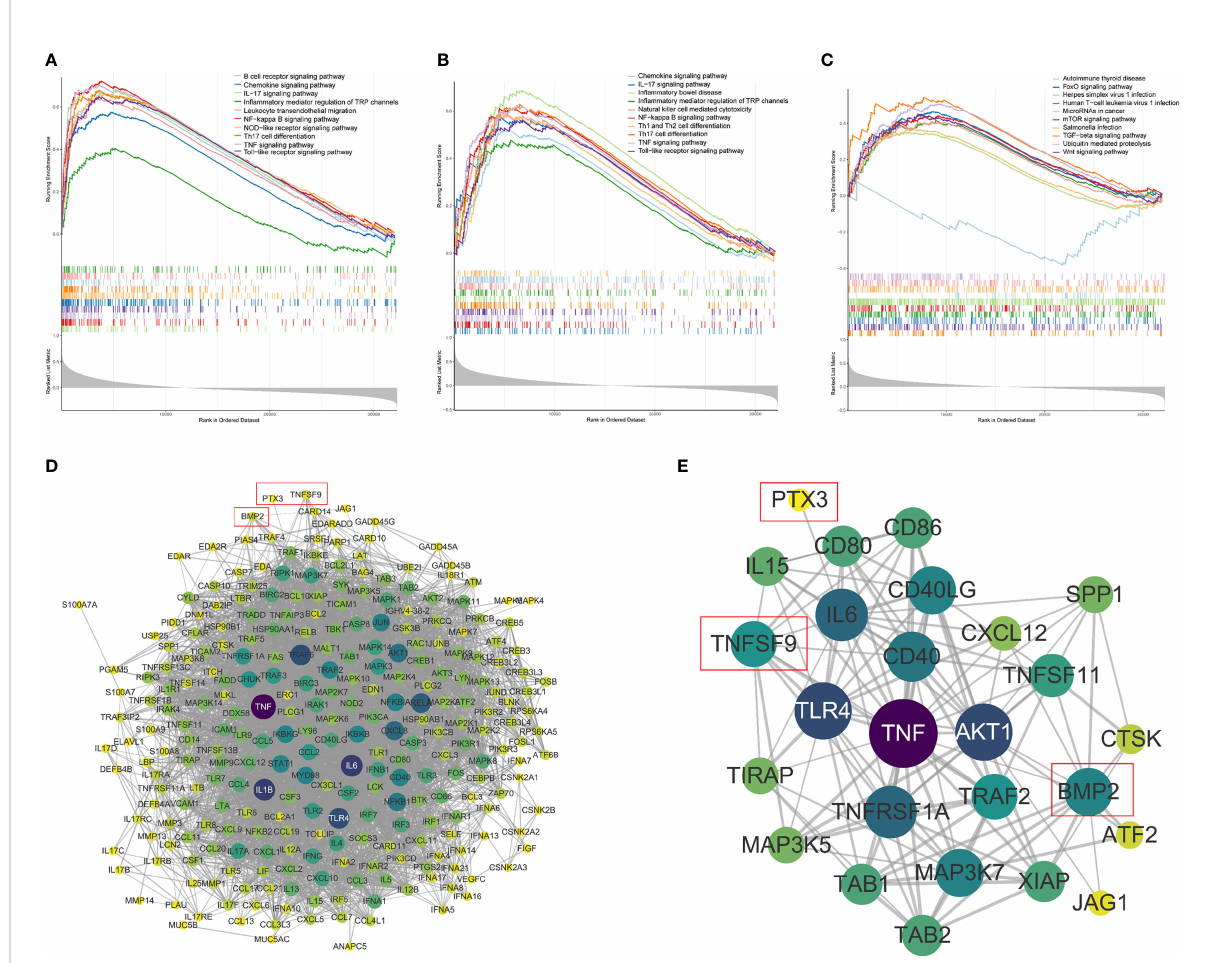
FIGURE 12 Single-sample gene set enrichment analysis (ssGSEA). (A – C) The ssGSEA of PTX3, TNFSF, and BMP2, including gene enrichment scores, hit and ranked list metric. (D) The PPI network between the model genes and the four genes directly related to in fl ammatory factor pathways (con fi dence = 0.6). (E) The PPI subnetwork related to PTX3, TNFSF9, and